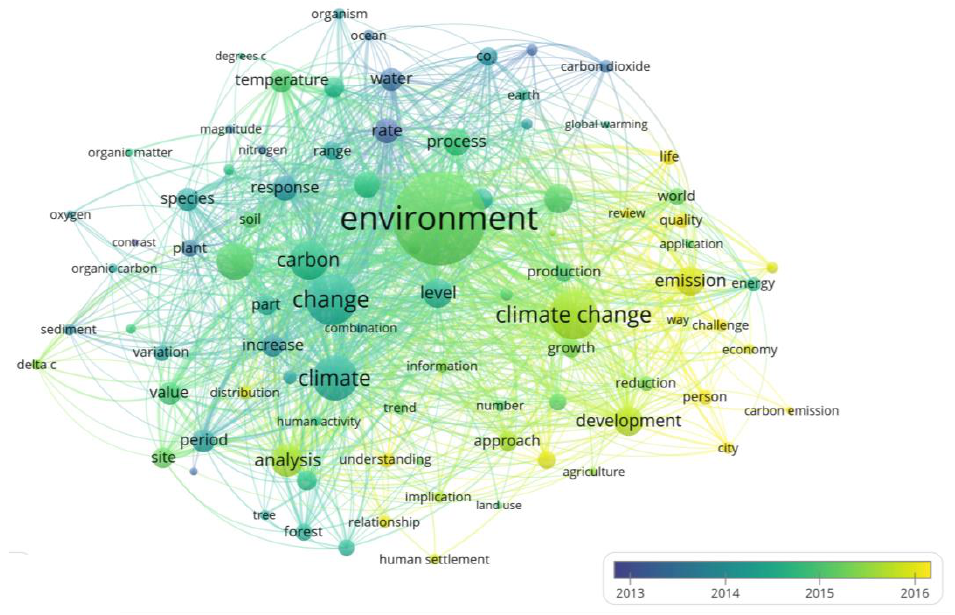
Figure 8. RCHSCC keyword annual overlap mapping.